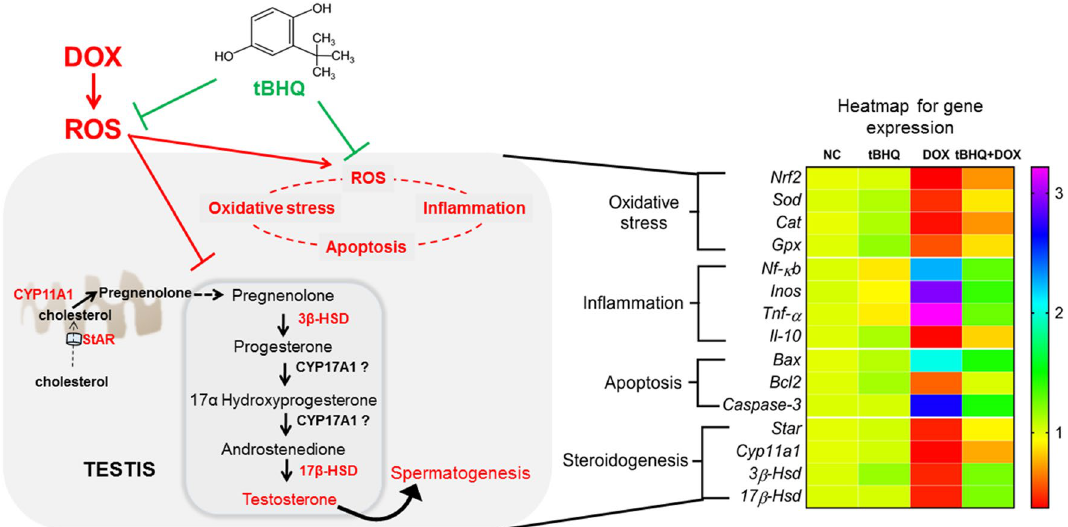
Figure 8. Schematic representation of the effect of tBHQ on DOX-induced testicular toxicity. DOX triggered ROS generation, causing oxidative stress, which in turn activated cytotoxic genes that control inflammation and apoptosis. Also, DOX-induced ROS generation altered genes that regulate steroidogenesis, causing testosterone decline and spermatogenesis impairment. However, pre-treatment with tBHQ offered some level of protection against DOX-induced toxicity as demonstrated by the heatmap of affected genes which have been grouped according to their targeted pathways. The heatmap key on the right side shows the expression levels of the genes; numbers greater than 1 depict upregulation while numbers below 1 depict downregulation. NC: normal control, tBHQ: tert-butylhydroquinone, DOX: doxorubicin, tBHQ + DOX: tert-butylhydroquinone +